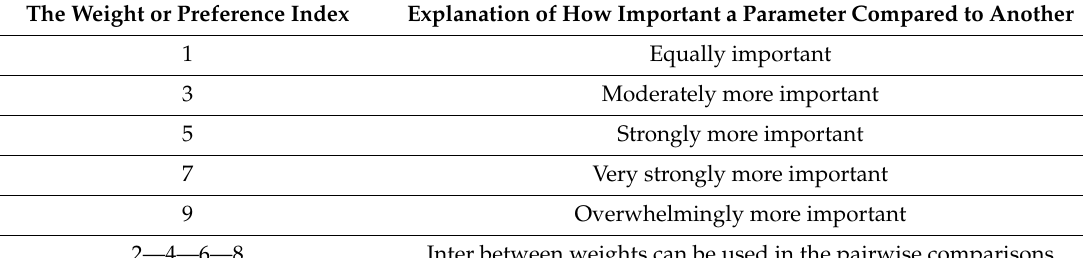
Table 3. The Analytic Hierarchy Process (AHP) method after Thomas